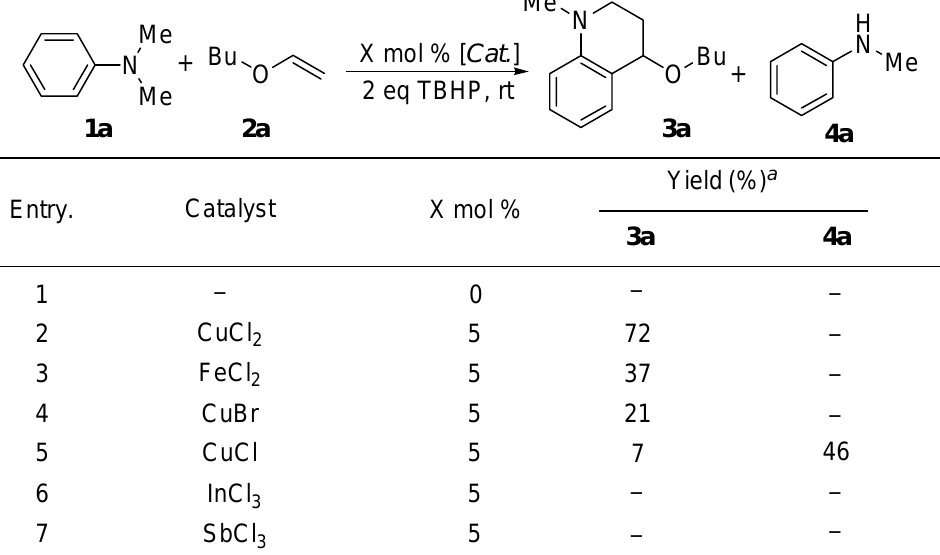
Table 1. One-pot synthesis of tetrahedroquinonline catalyzed by Lewis acid